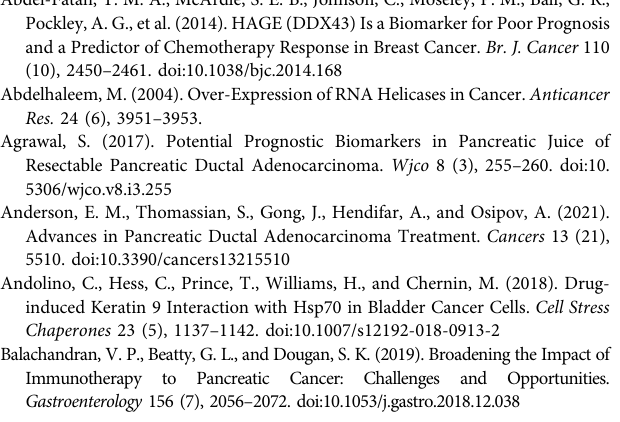
Supplementary Figure S5 | Single-nucleotide variation (SNV) and copy number variation (CNV) of targeted genes in TCGA samples. (A) : Percentage and types of SNV in TCGA samples. (B) : Top ranking genes withhigh percentage ofSNV inhigh- risk score group of TCGA samples. (C) : The percentage of CNV of CAP1 , CD59 , DDX31 , and YAP1 in PDAC samples of TCGA. Supplementary Figure S6 | Immuno fl uorescence of DDX31 in PC cell lines. (A) : Immuno fl uorescence of DDX31 in SW1990 and MIA-PaCa2 cell lines. Supplementary Figure S7 | The functionalveri fi cation work of DDX31 in HPDE6c7 (normal pancreatic ductal epithelial cells). Supplementary Figure S8 | The spearman ’ s correlation analysis between DDX31 andthecoremoleculesin MAPK signalingpathway. (A) :Thespearman ’ scorrelation analysis between DDX31 and the top50 genes in MAPK signaling pathway; (B) : The spearman ’ s correlation analysis between DDX31 and the top50 to top100 genes in MAPK signaling pathway; p value < .001; R >